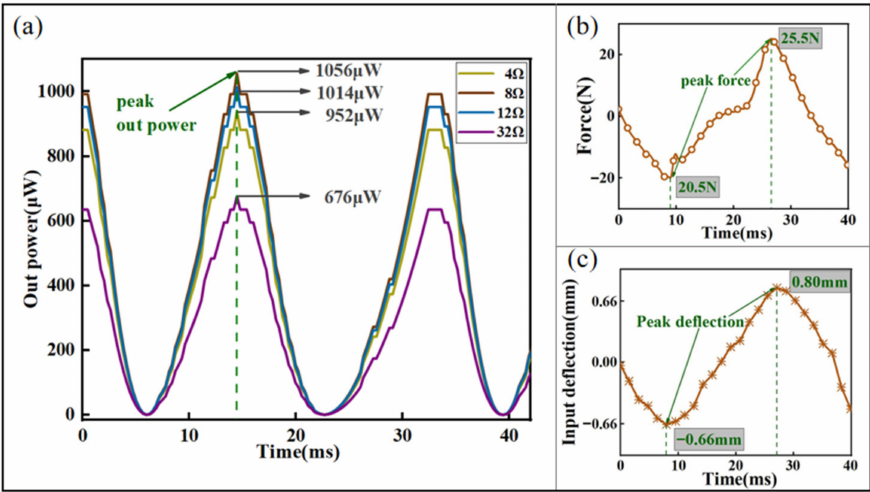
Figure 21. Output characteristics of the double-stage rhombus energy harvesting device under 30 Hz sinusoidal excitation. ( a ) Output power; ( b ) Force input signal; ( c ) Displacement input